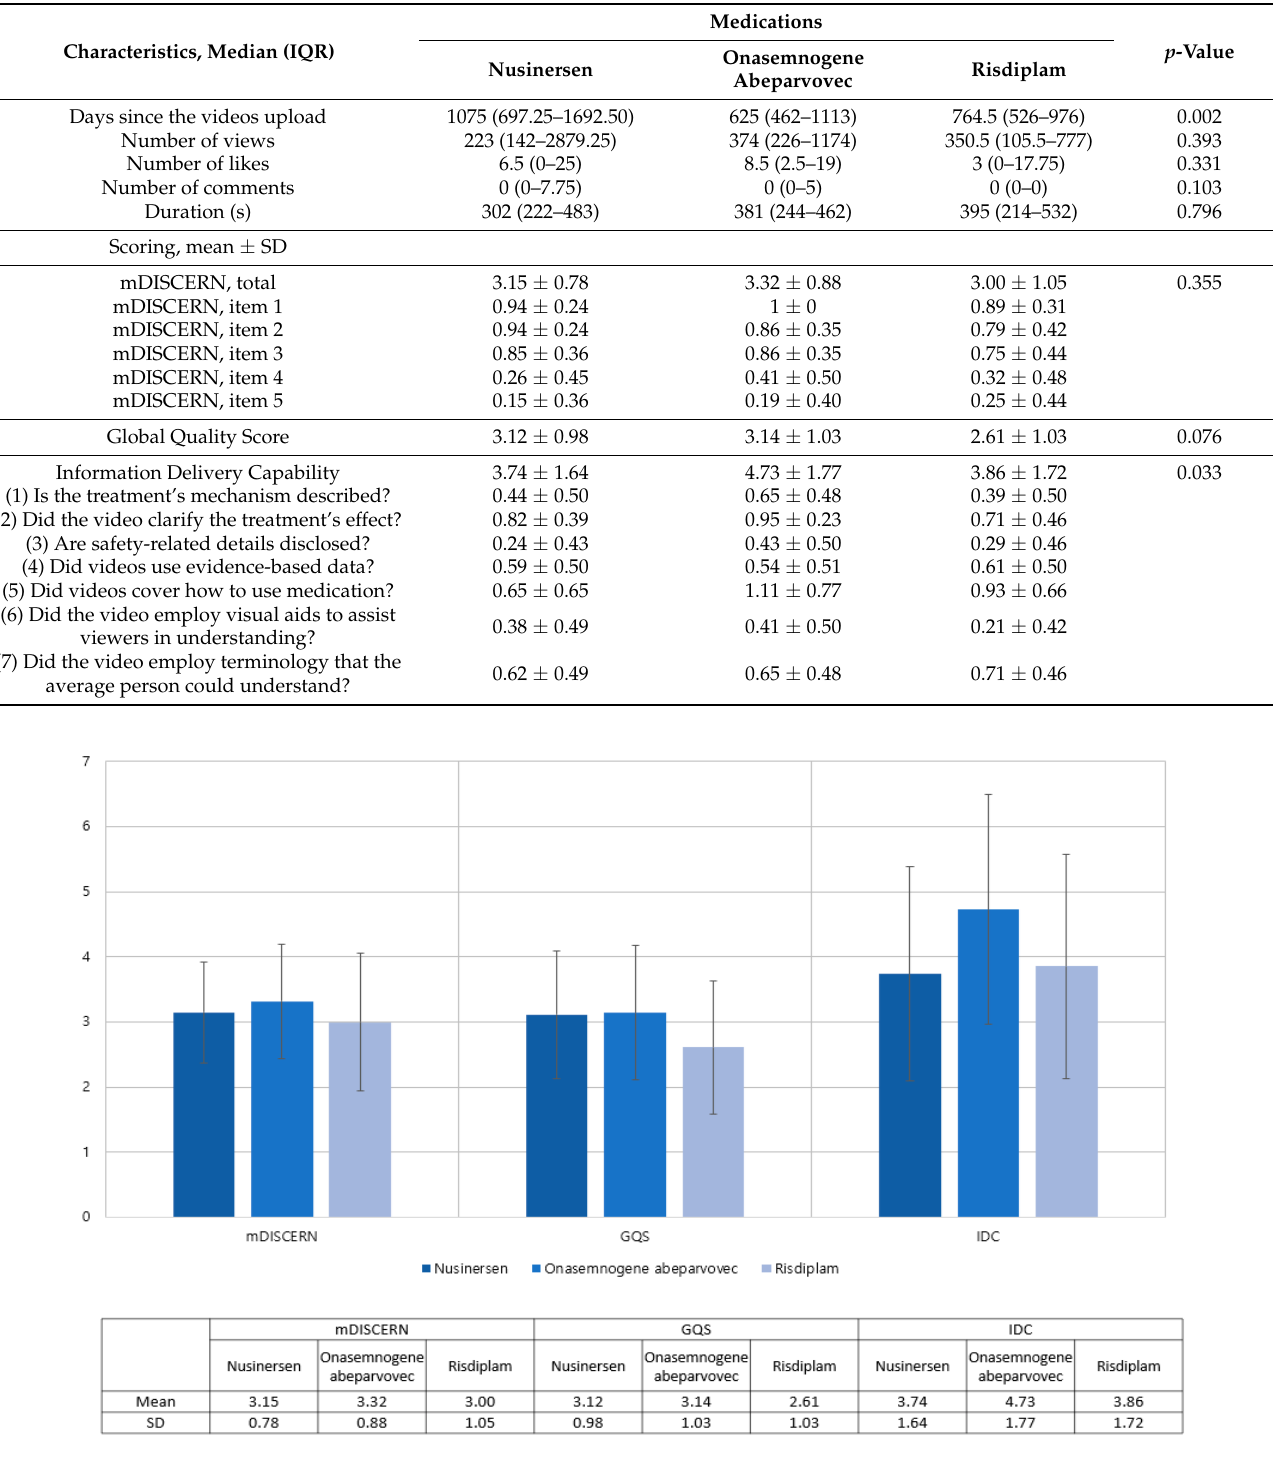
Figure 3. Distribution of mDISCERN, GQS, and IDC across the type of medications.